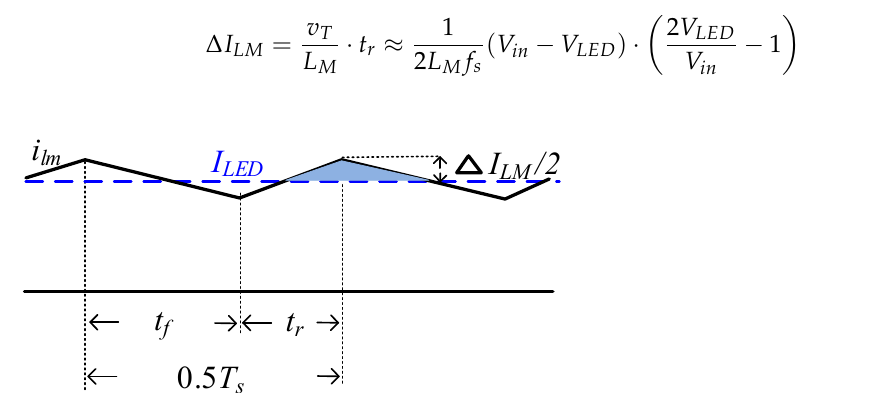
Figure 6. Conceptual waveform of the magnetizing